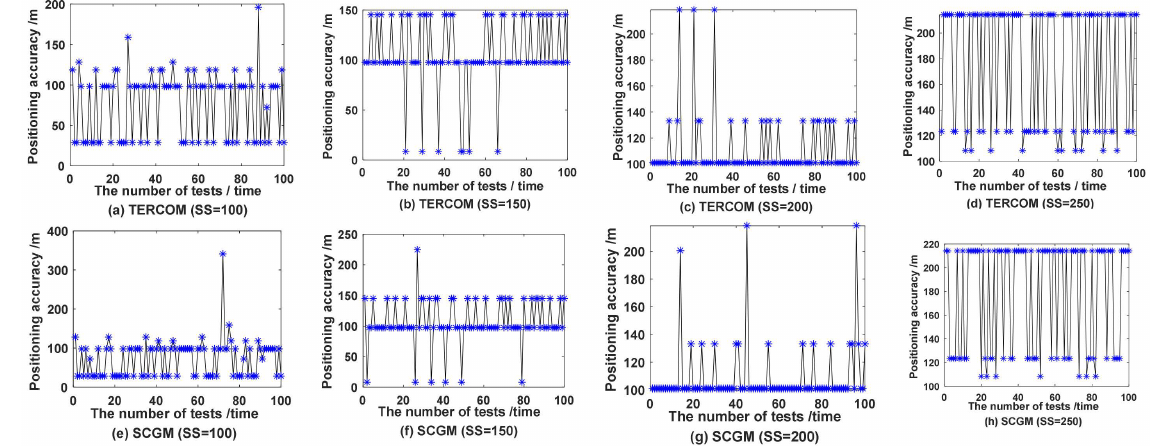
Figure 5. Comparison on positioning accuracy under different sampling scales.